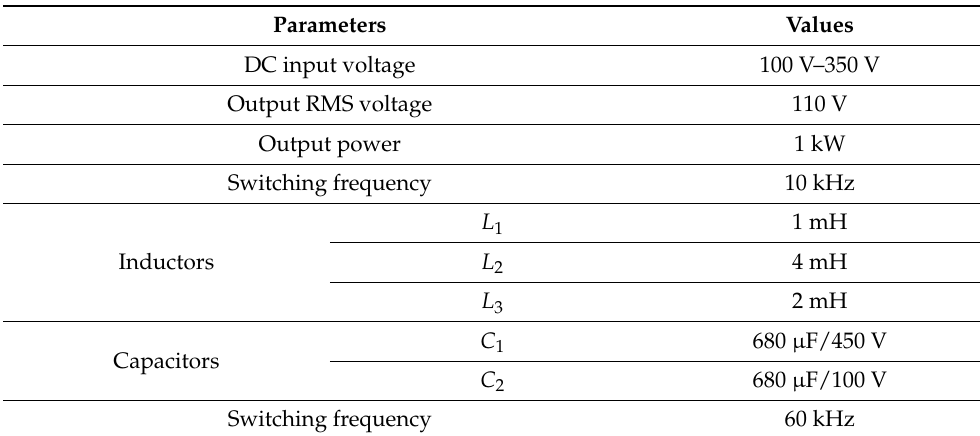
Table 4. Parameters of the MAqZSI.